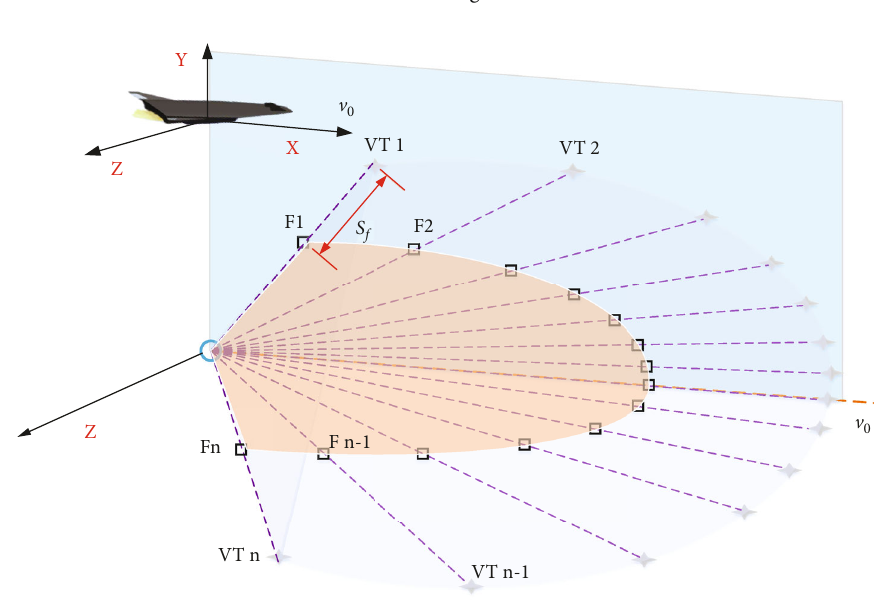
Figure 2: Schematic diagram of the vehicle ’ s reachable area.